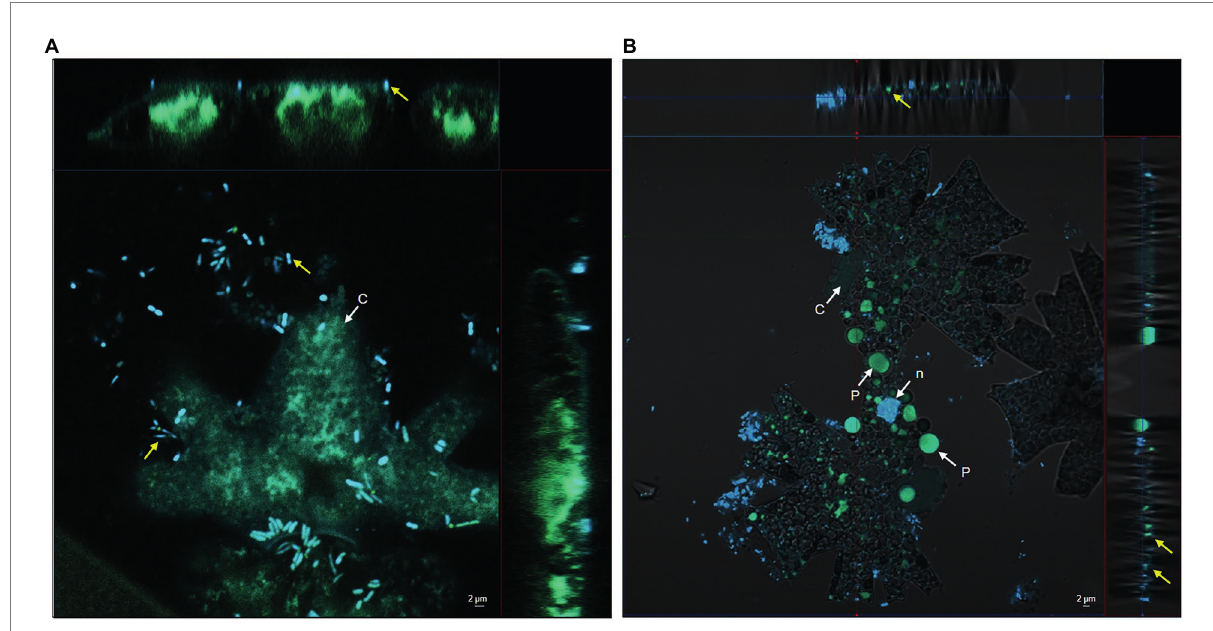
FIGURE 1 Confocal microscope including Z-Stack images of Dyadobacter sp. HH091 expressing eGFP (yellow arrows) found in a close proximity to Micrasterias radians MZCH 672. Autofluorescence Quenching Kit was used to lower the autofluorescence of chlorophyll of the microalga. Structures: c chloroplast, n nuclear region, p pyrenoid. Scale bar = 2 μ m in each micrograph. (A) First day of incubation. (B) Third day of